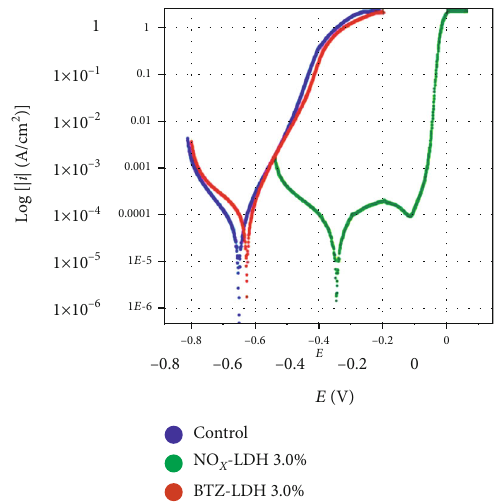
Figure 11: Potentiostatic polarization curves obtained for di ff erent LDH extract systems ( E vs. Ag/AgCl reference electrode and scanning speed of 1 mV · s - 1 ).